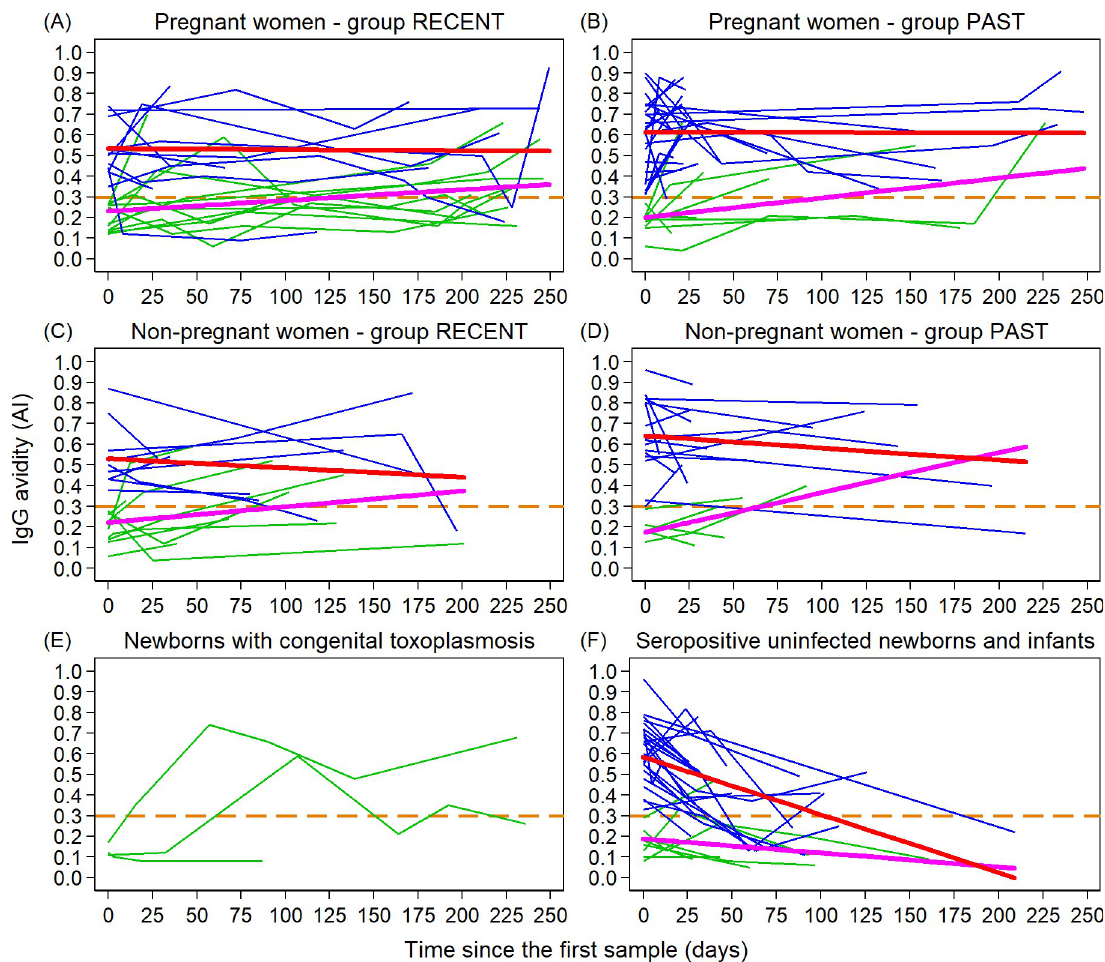
Fig 1. Kinetics of the avidity index (AI) in individual patients followed-up with 2–6 samples, starting with low (AIF0A30.3—green) or high (AI > 0.3—blue) IgG avidity in the course of toxoplasmosis. The trend lines obtained from the regression model are marked in purple for patients with low avidity, and in red for patients with initial high avidity. Graphs (A) and (B) represent pregnant women, graphs (C) and (D) non-pregnant women, while graph (E) includes congenitally infected newborns and (F) seropositive uninfected newborns and infants up to six months of age. Graphs (A) and (C) are related to the recent acute toxoplasmosis, graphs (B) and (D) to the past toxoplasmosis. The low avidity threshold of 0.3 is indicated by the dashed orange